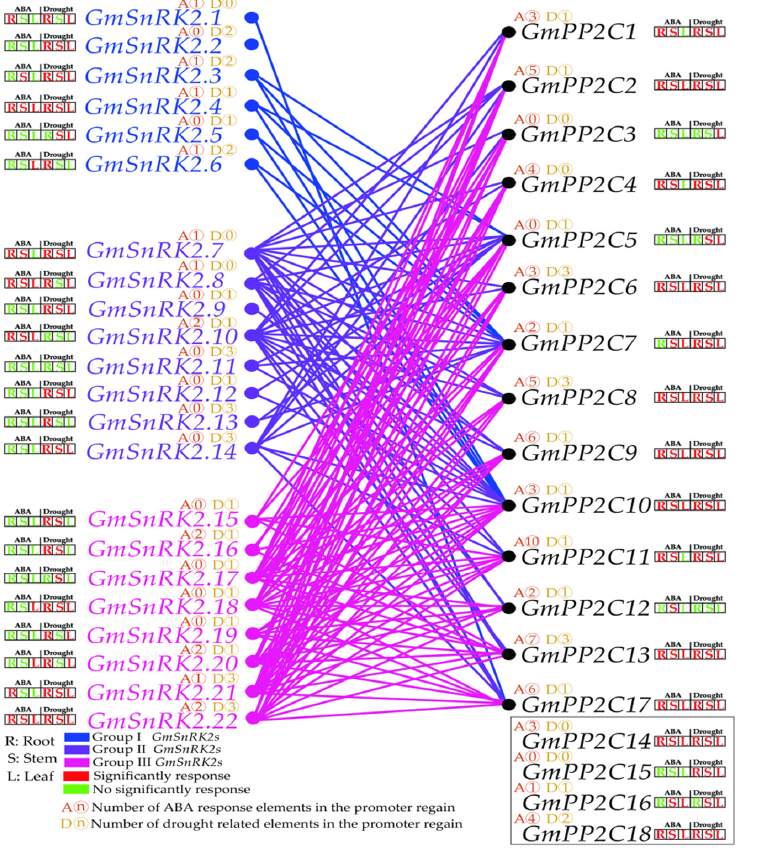
Figure 11. Comprehensive analysis of the expression patterns in response to ABA, drought signals and the interactions between the GmPP2C-A and GmSnRK2 family members in soybean plants. The black solid line box represents the GmPP2C-As members that did not interact with GmSnRK2s, according to the Y2H assay results.